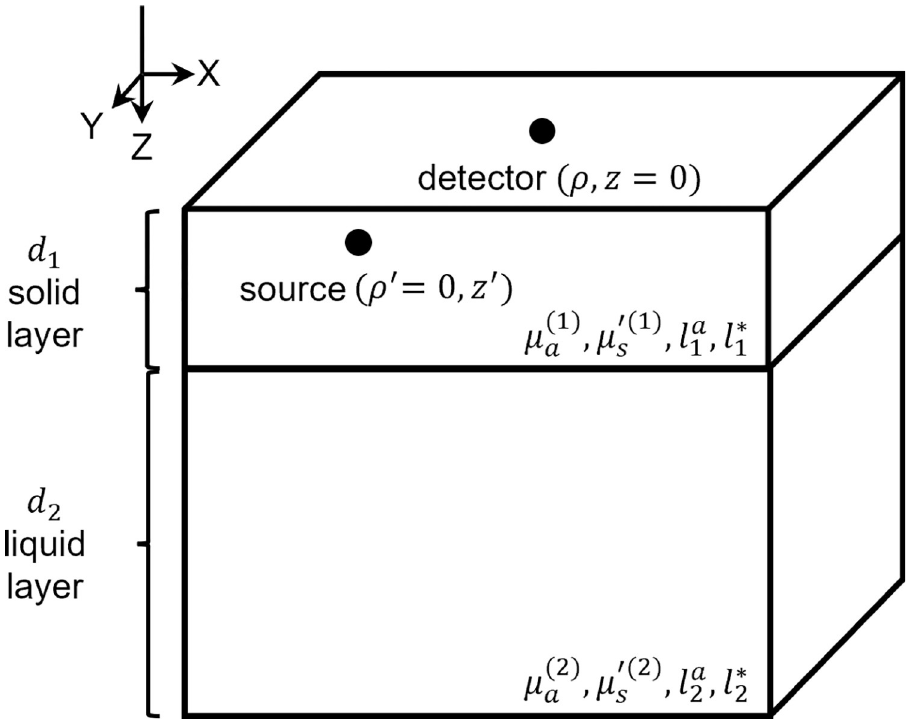
Fig 1. Schematic of the two-layer scattering medium including locations of the source and the detector. Here, m ð n Þ and m 0ð n Þ are the absorption and reduced scattering coefficients, l � s absorption mean free path, for the respective layers where n = 1–2. The top layer is the solid layer with finite thickness ( d 1 ), the bottom layer is the liquid layer with semi-infinite geometry ( d 2 ).